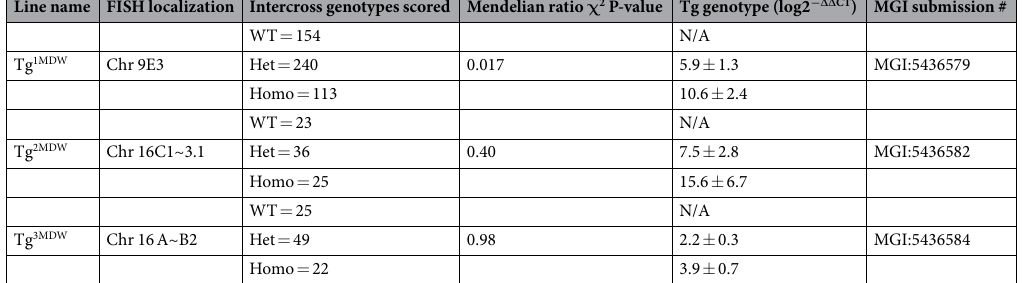
Table 1. Tg-(GFAP- Mir183,Mir96,Mir182 ) line